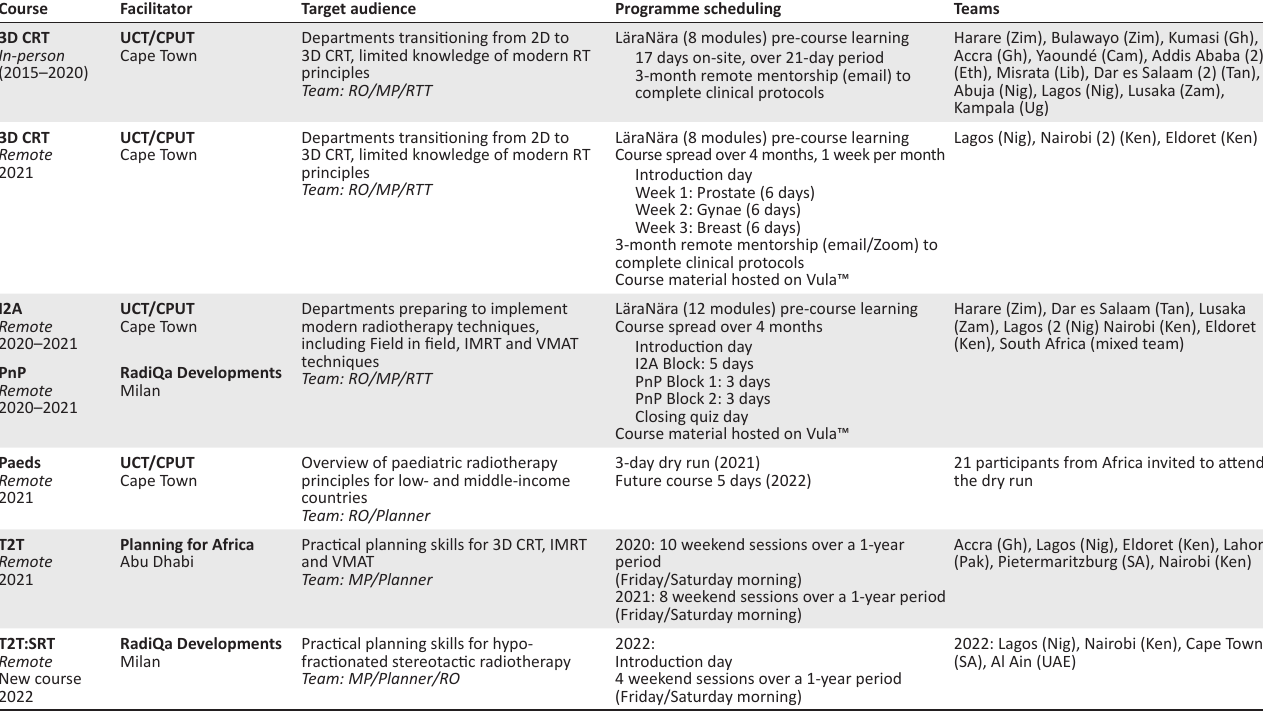
TABLE 2: Overview of access to care Cape Town courses: January 2015–January